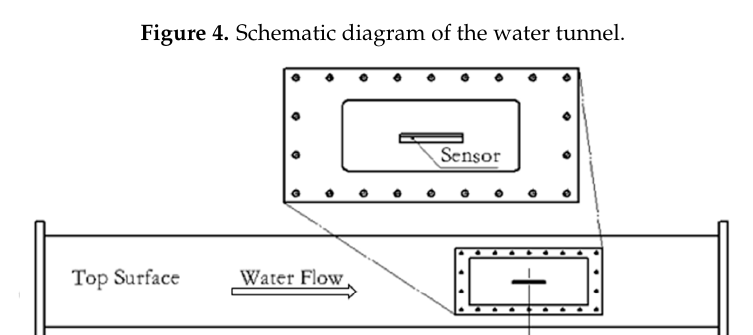
Figure 4. Schematic diagram of the water tunnel.